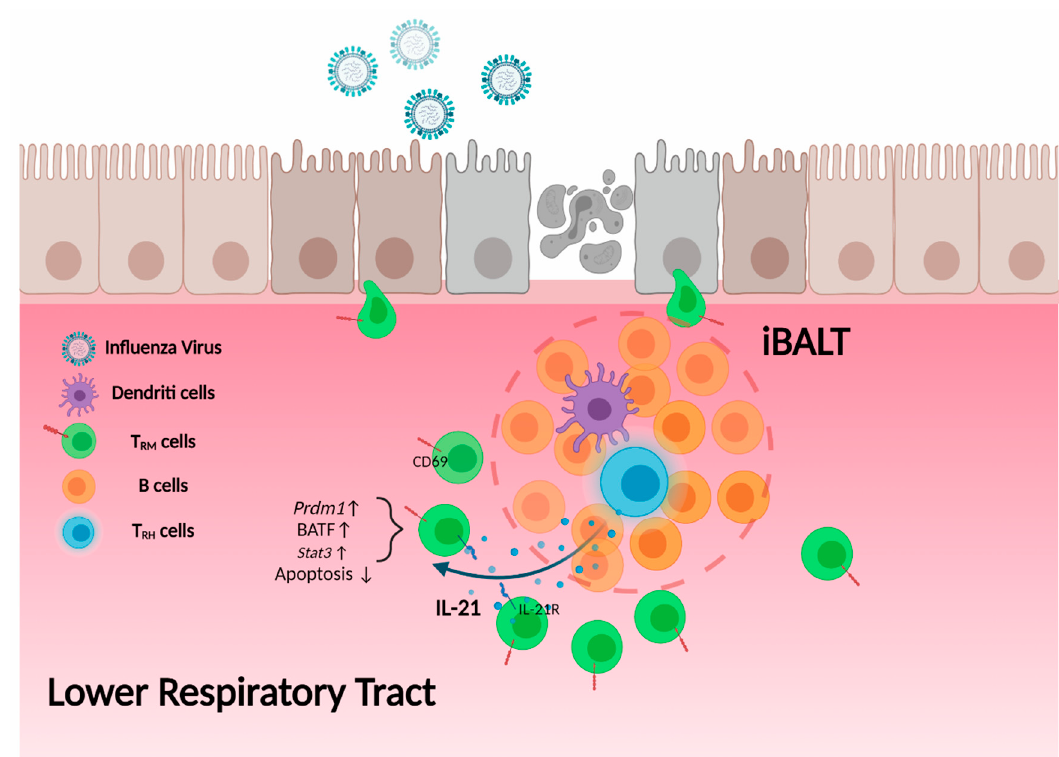
Figure 2. T RH cell help to CD8 T RM cells. T RH cells, which localize within the iBALT, secrete IL-21. Influenza NP 366–374 -specific CD8 T RM cells are located outside but near the border of iBALT structure and express high levels of IL-21 receptor. IL-21 secreted from T RH cells promotes the expression of Blimp-1 (Prdm1), BATF and other molecules in CD8 T RM cells, thereby maintaining NP 366–374 -specific T RM cell retention and survival in the lung.